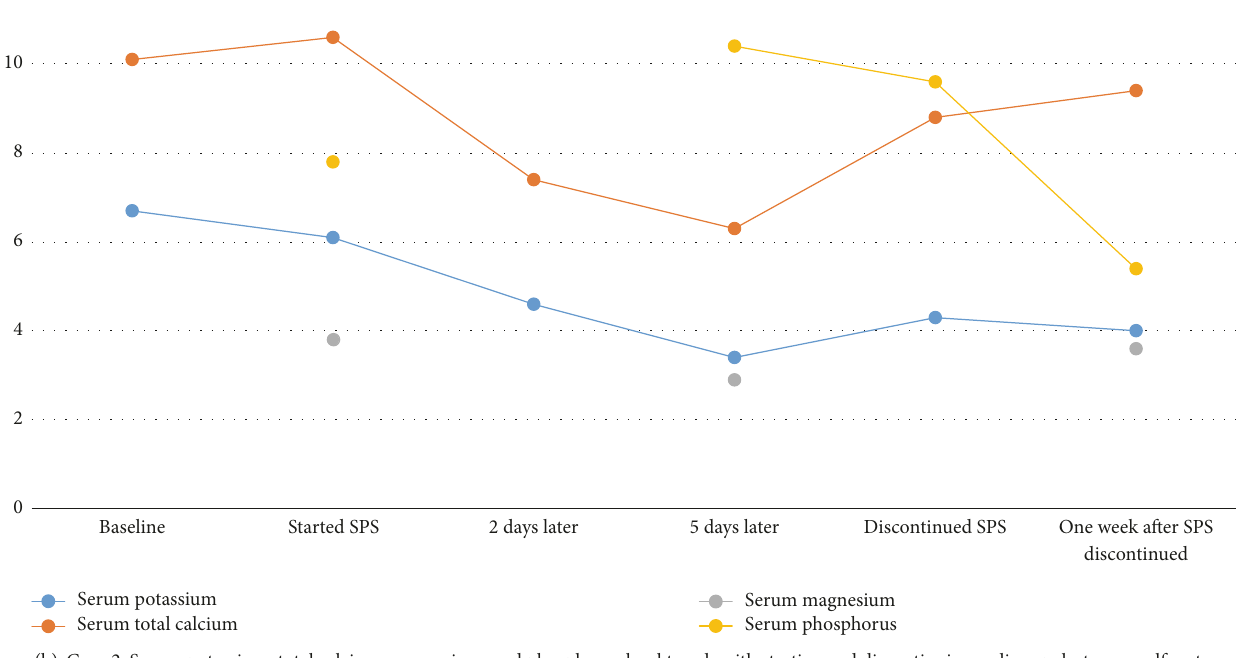
was about 130/min and blood pressure was 102/58 mmHg. He had no tetany, normal deep tendon reflexes, a negative Chvostek sign, and no electrocardiogram (EKG)